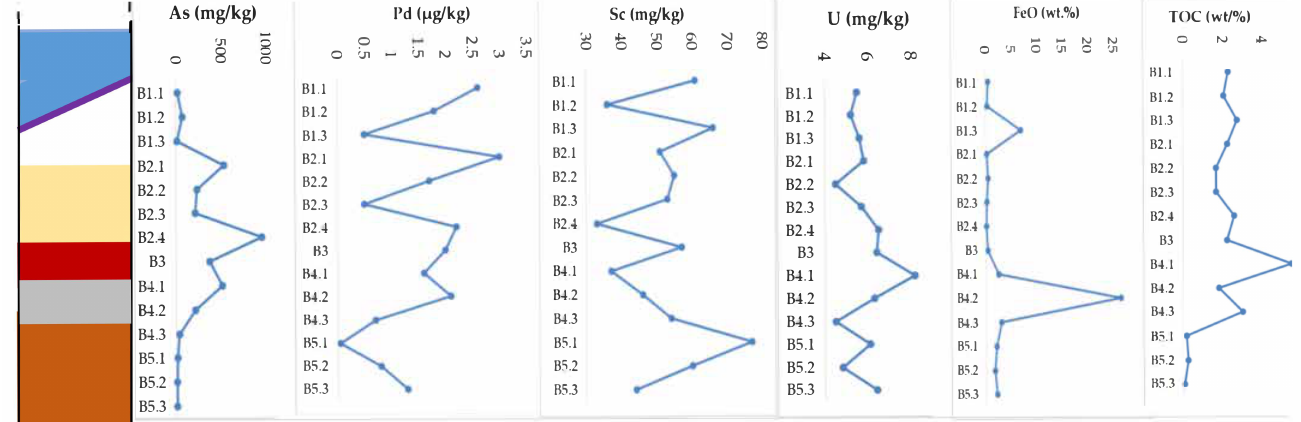
Figure 5. Schematic compositional variations for As, Pd, Sc, U, FeO, and TOC, through a vertical bauxite profile (Figure 1). Data are from Table 1.